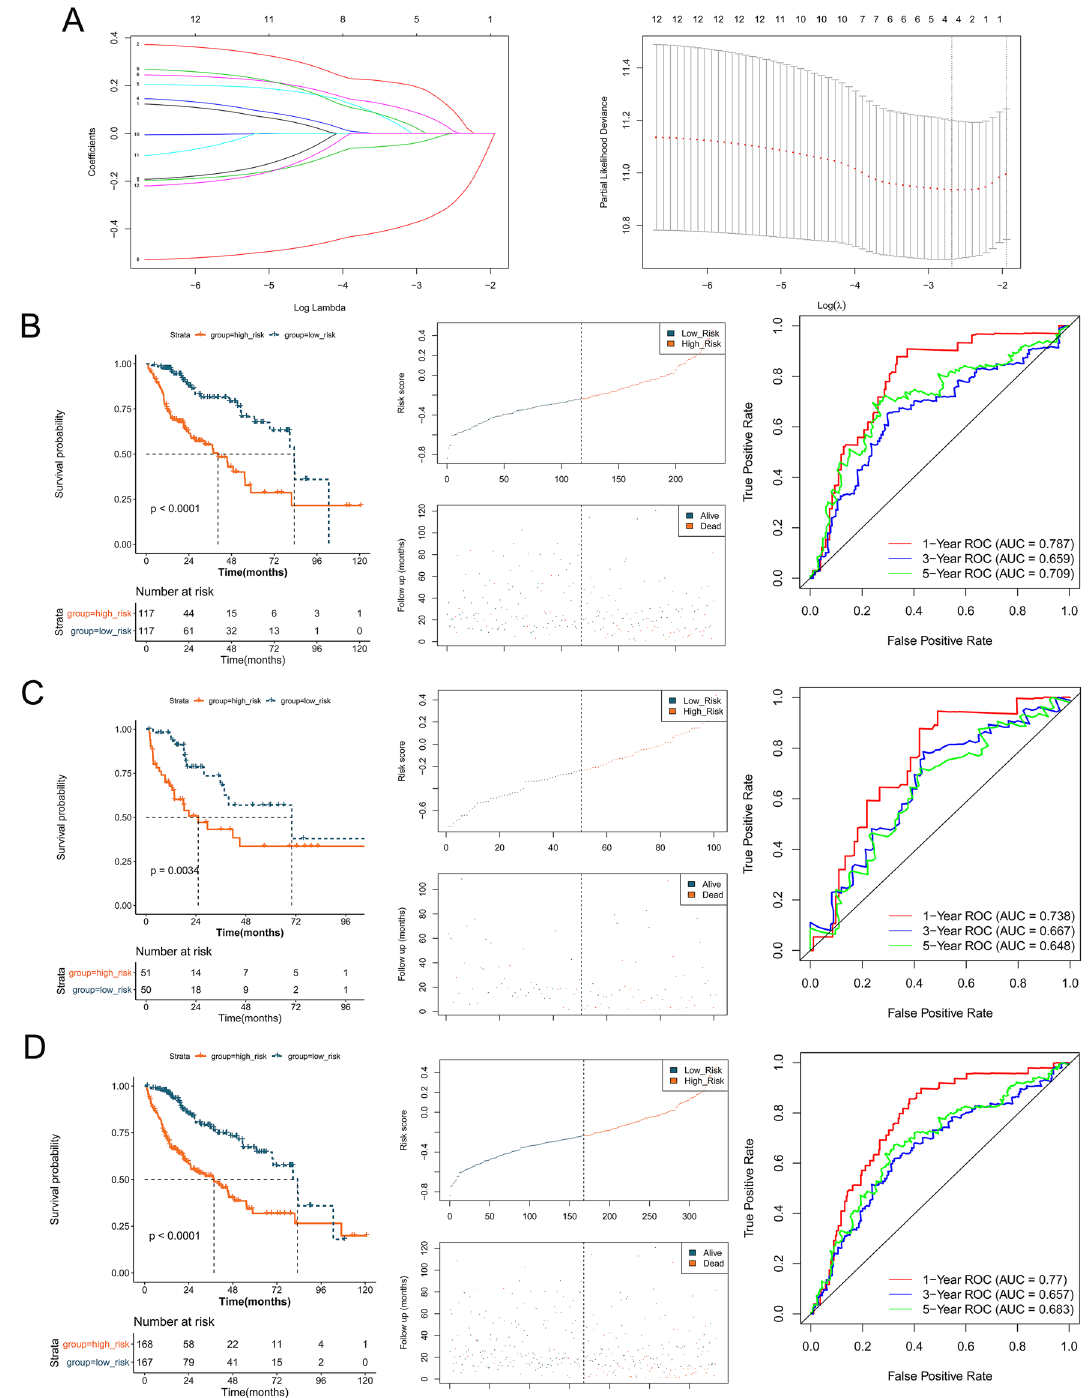
Figure 5. Identification of lncRNA prognostic markers with abnormal copy number and establishment of lncRNA signature. ( A ) LASSO Cox regression analysis. The left vertical line in the plot shows the CV-error curve hits its minimum. The right vertical line shows the most regularized model with CV-error within 1 standard deviation of the minimum. Kaplan–Meier survival analysis, plots of risk scores distribution, time- dependent receiver operating characteristic (ROC) analysis for the ( B ) training set, ( C ) testing set, and ( D ) validation